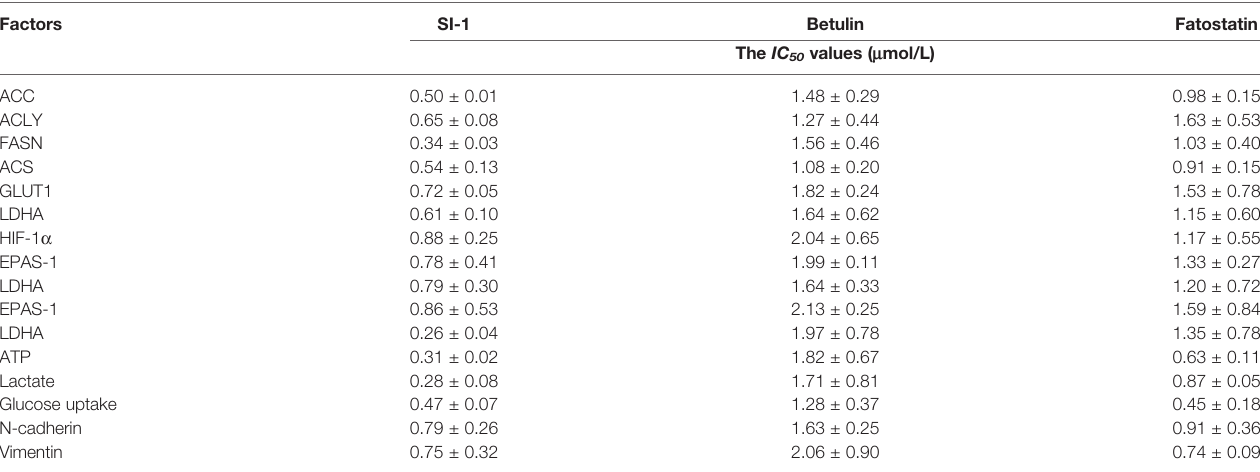
TABLE 2 | The activation of SI-1 compared with the Betulin or Fatostatin. Factors